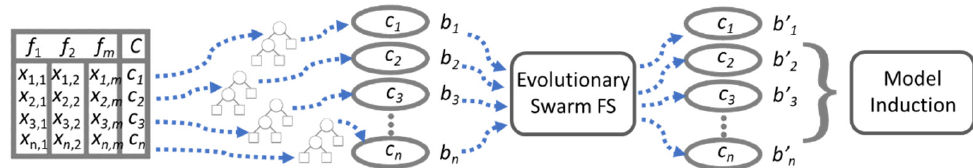
Figure 4. Process of expand-and-contract instance-based learning (EAC-IBL) involving an evolutionary feature selector.